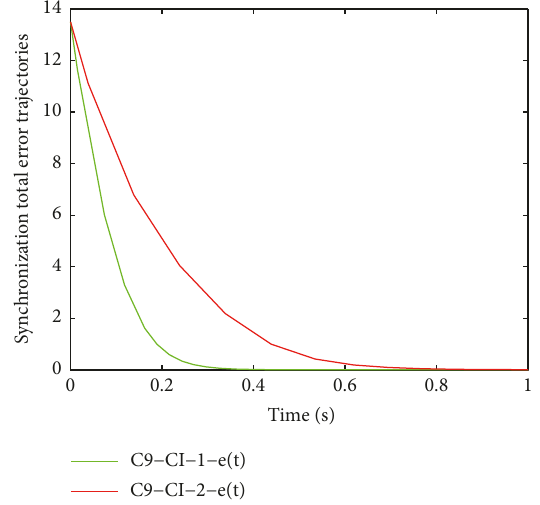
Figure 10: Synchronization total error trajectories of the network (36) for the case I-1 and I-2 of Corollary 27.